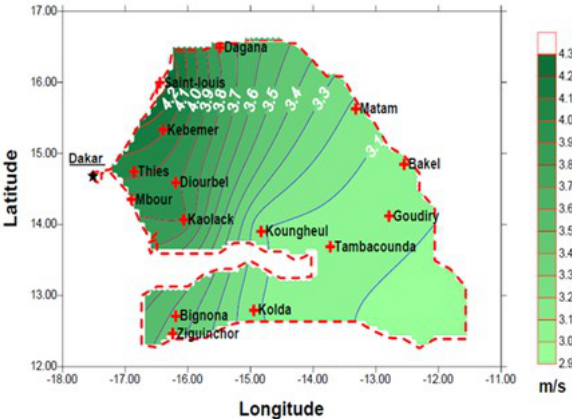
Figure 1: Senegal’s wind card measured at 10 m